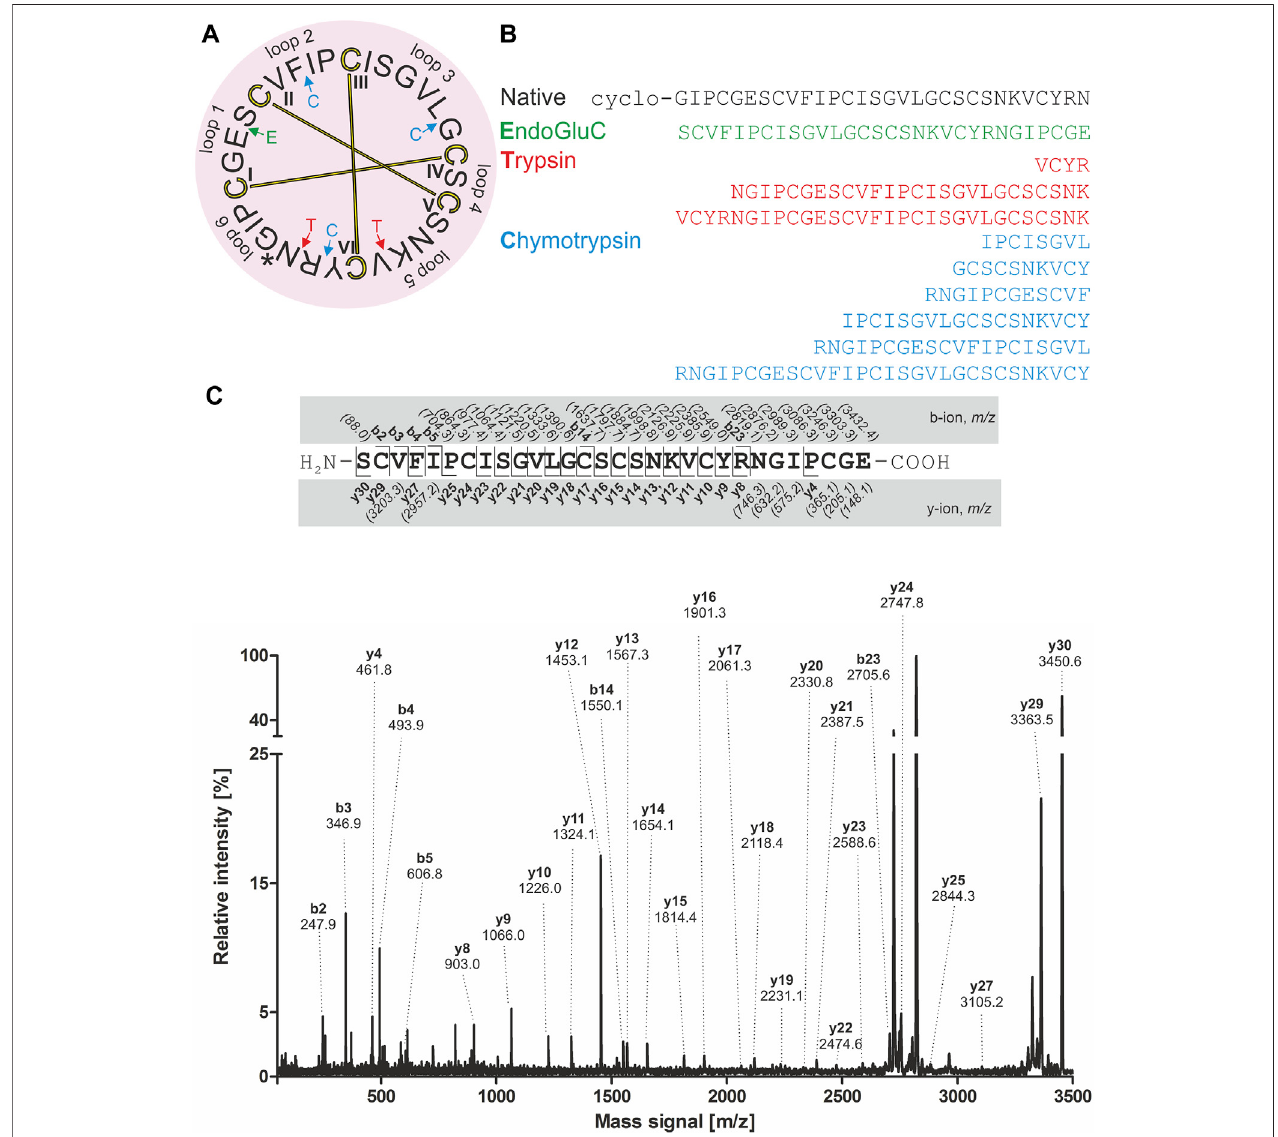
FIGURE6| Aminoacidsequenceanalysisofalca2.Isolatedalca2peptidewithnative m/z 3,084.2waspreparedformassspectrometricexperimentswithcollision induced fragmentation. The determined amino acid sequence is shown in a circular plot. The observed cleavage sites for endoprotease GluC (green), trypsin (red) and chymotrypsin (blue) are indicated with arrows. The cystine knot con fi guration was assumed by homology for cyclotides (cysteine are numbered and connected as follows: I-IV, II-IV and III-VI) and disulphides are indicated with connecting bars in yellow. The intercysteine loops are numbered with 1, 2, 3 etc., starting after the native ligation site (indicated with an asterisk) (A). The observed peptide fragments in MS analysis were denoted in one letter amino acid code (B) . The ion fragment spectra of peptide precursor m/z 3,450.6 derived from proteolytic cleavage by endopeptidase GluC is shown with labelling of the corresponding ions. The determined aminoacidsequenceisshownonthetopfromN-totheC-terminus.Theidenti fi edy-andb-ionsseriesarelabelled( e.g. y 1 ,y 2 ,etc.)andmissingsignalsareitalicnumbers in brackets. The fragmentation spectrum was assigned with all annotated ion signals (C) .